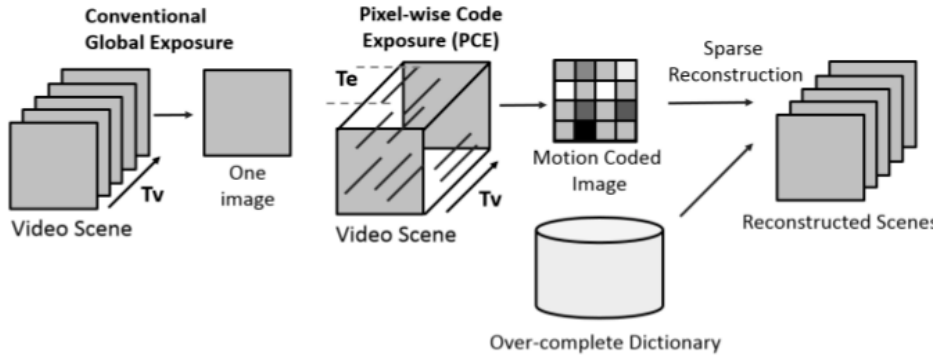
Figure 1. Conventional camera vs. Pixel-wise Coded Exposure (PCE) Compressed Image/Video Sensor [2].